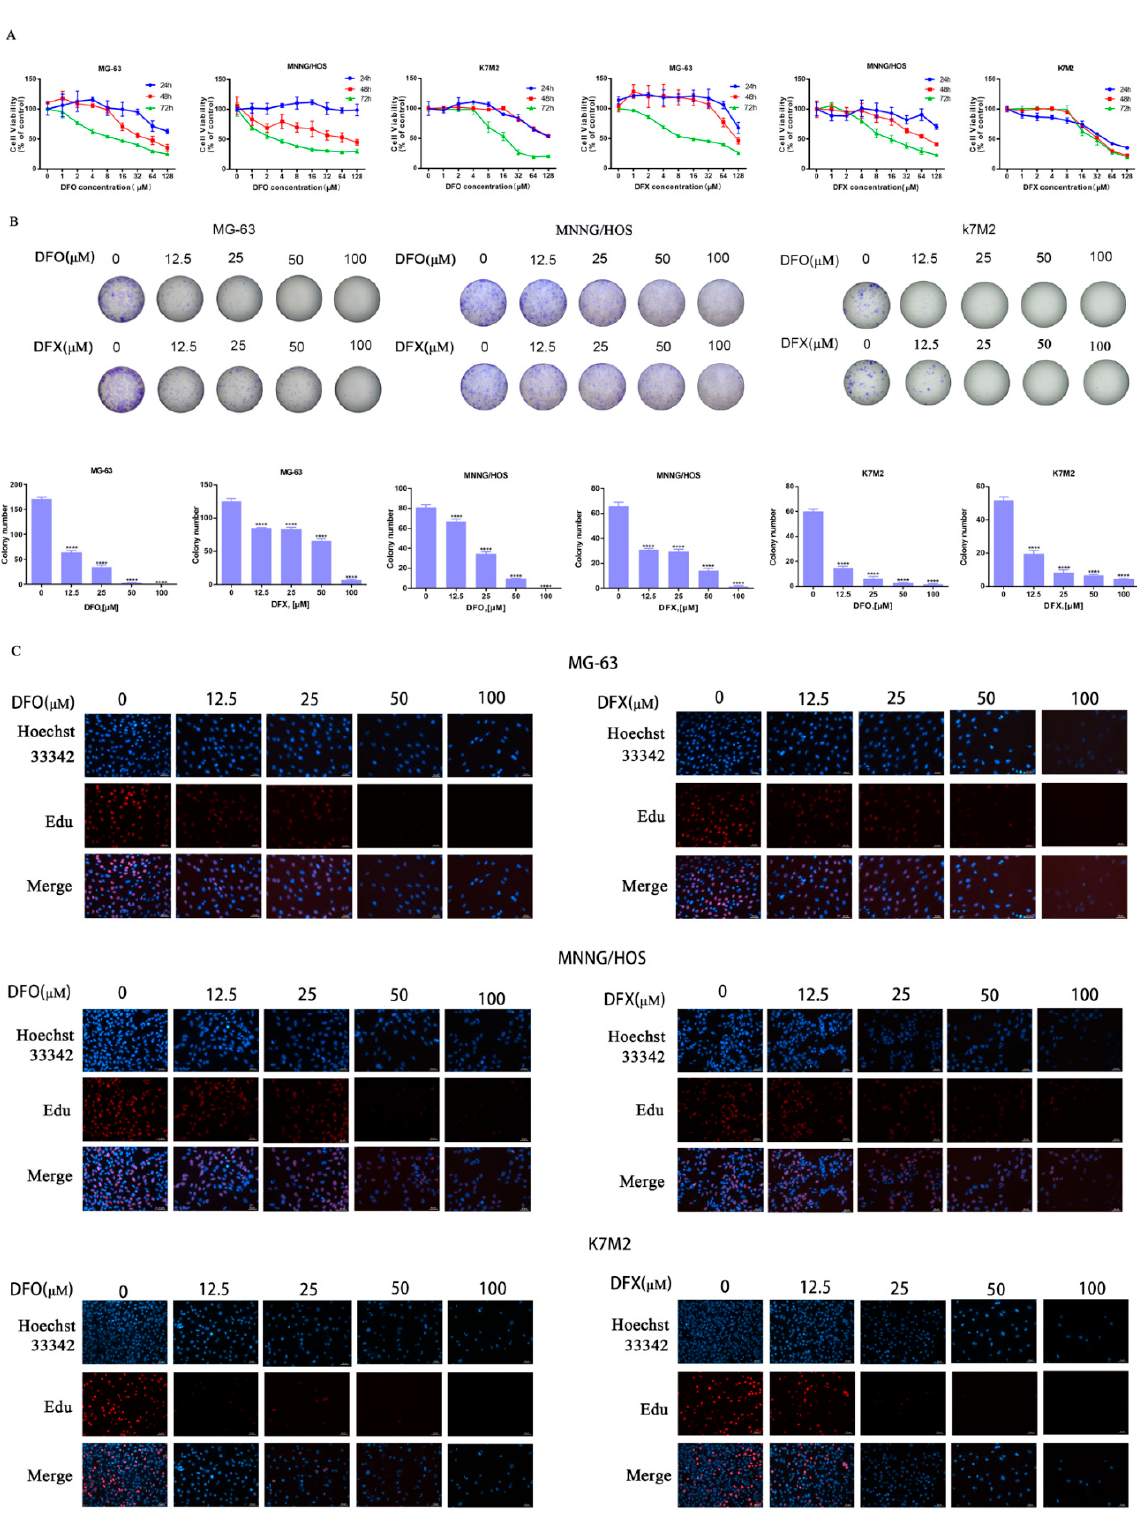
Figure 1. Iron chelators inhibited cell viability and proliferation of osteosarcoma cells. ( A ) Viability of MG-63, MNNG/HOS and K7M2 cells treated with a series of concentrations of DFO and DFX for 24 h, 48 h or 72 h. The data are presented as mean ± SD (n = 5). ( B ) Colony formation assay of MG-63, MNNG/HOS and k7M2 cells treated with DFO and DFX. The data are presented as mean ± SD (n = 3). ( C ) EdU staining assay of MG-63, MNNG/HOS and K7M2 cells treated with DFO and DFX for 48 h. **** p < 0.0001 versus control group.